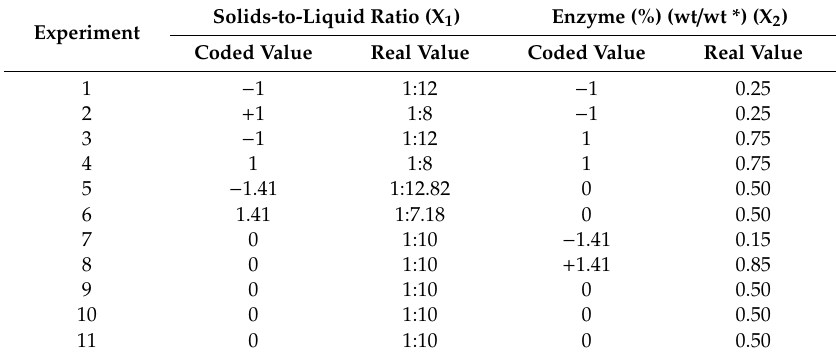
Table 2. Variables and levels evaluated in the optimization of oil and protein extraction in the enzyme-assisted aqueous extraction process (EAEP) of almond